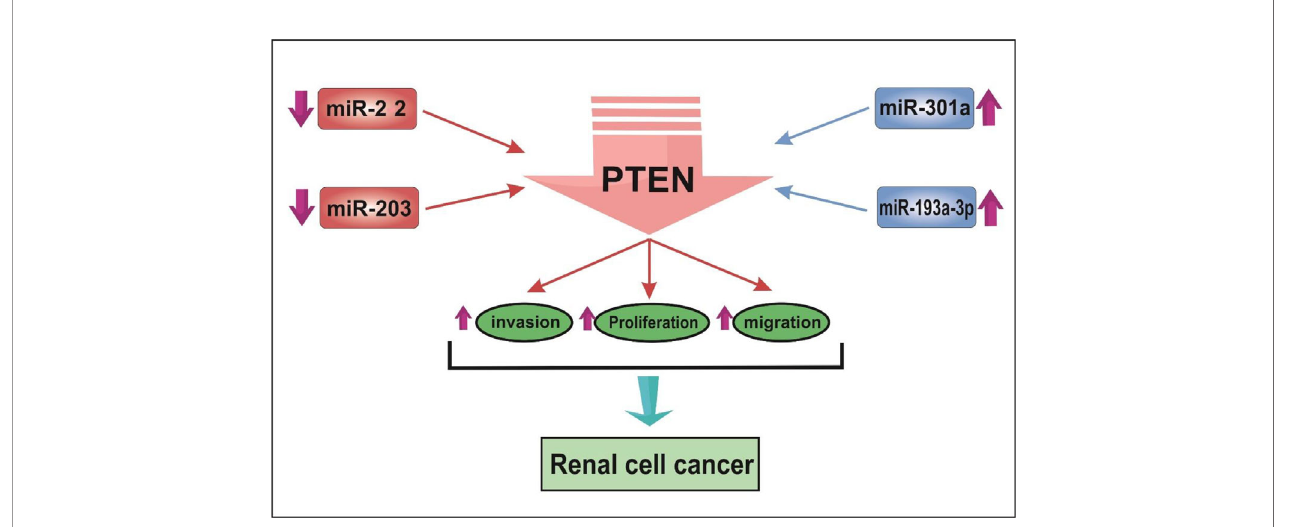
FIGURE 1 | The schematic depiction of the interplay between miRNAs and tumor-suppressive gene PTEN in renal cell cancer. MiR-22 and miR-203 are decreased, while miR-301 and miR-193a-3p are up-regulated in RCC. miRNA expression changes result in reducing the expression of PTEN. Consequently, cell proliferation, invasive behavior, and migration are enhanced in